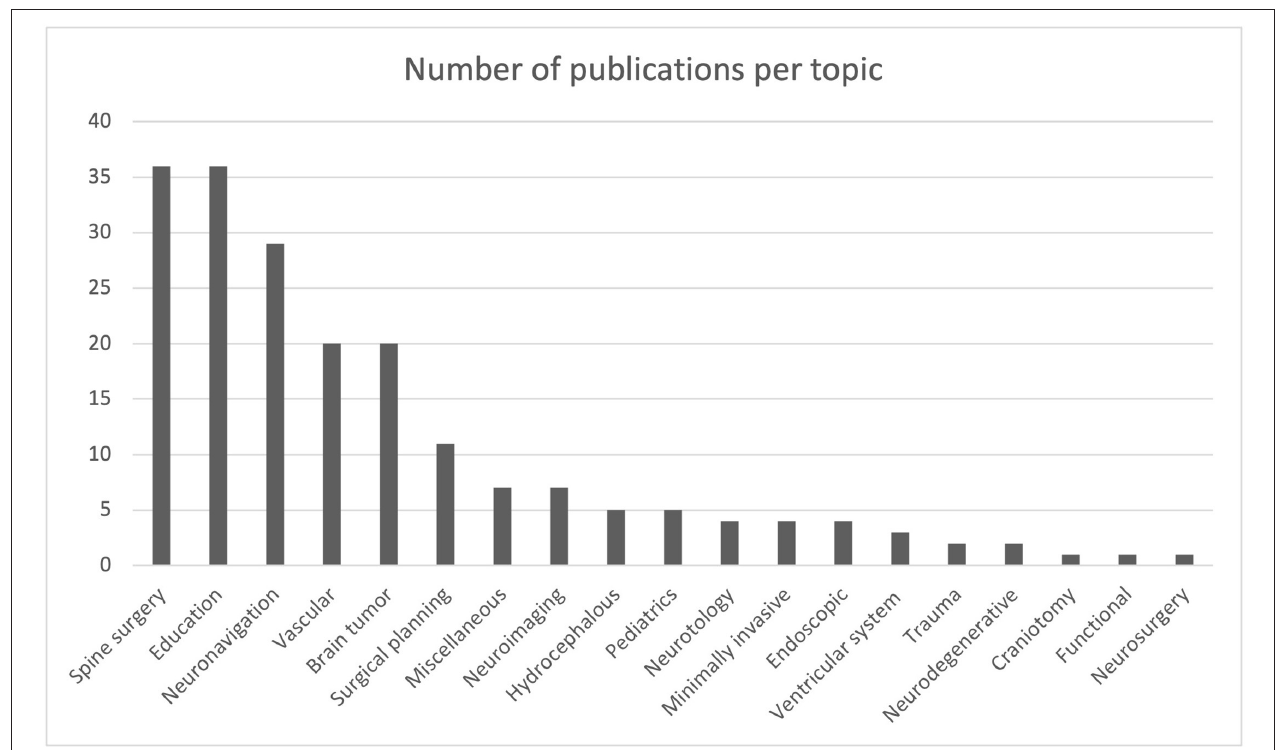
FIGURE 5 | Diagram representing the number of publications per